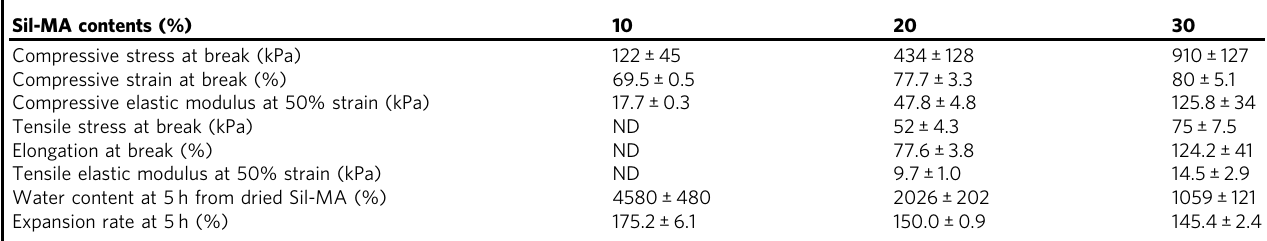
Table 3 Mechanical properties of Sil-MA hydrogel depending on Sil-MA contents Sil-MA contents (%) Compressive stress at break